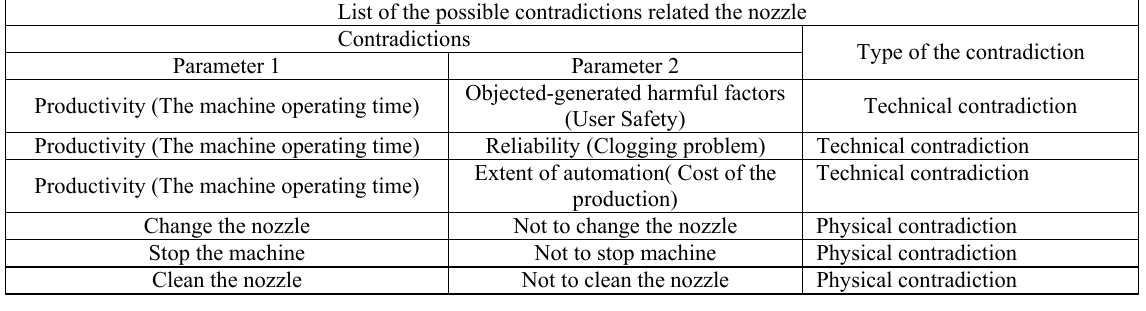
Table 2. Table of technical Contradictions Evaluation